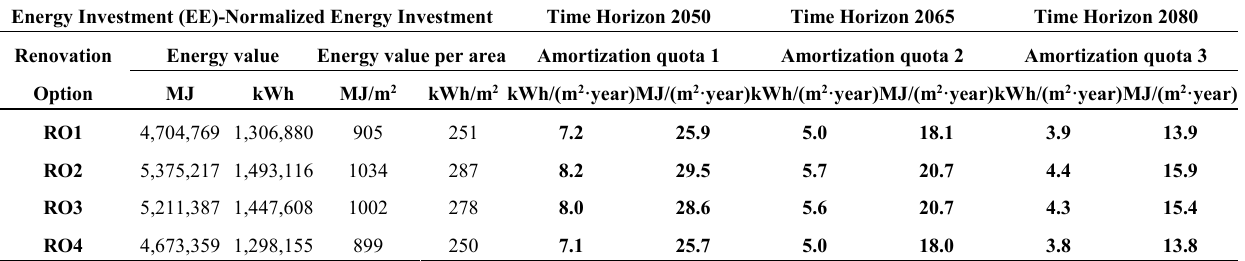
Table 6. Energy investments amortization quota for each RO according to assumed time